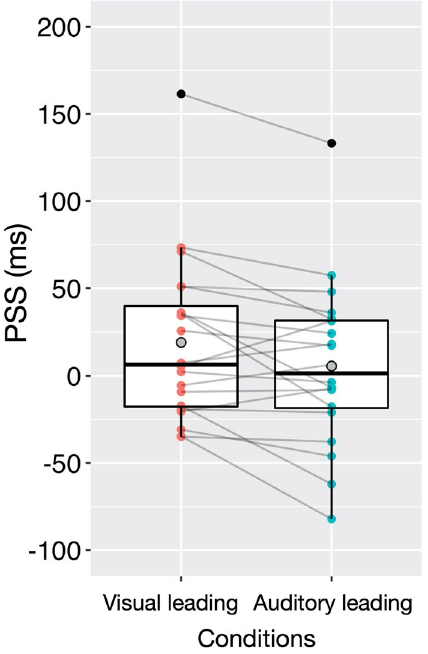
Figure 2. PSS data as a function of the adaptation condition (visual leading or auditory leading) in Experiment 1. Boxes represent the interquartile ranges (IQRs), central horizontal lines the medians, and grey circles the means. Magenta and cyan points represent the PSS data of individual participants. The vertical lines represent the ranges from “the first quartile − 1.5 × IQR” to “the third quartile + 1.5 × IQR,” and black points indicate the PSS data outside the ranges (i.e.,